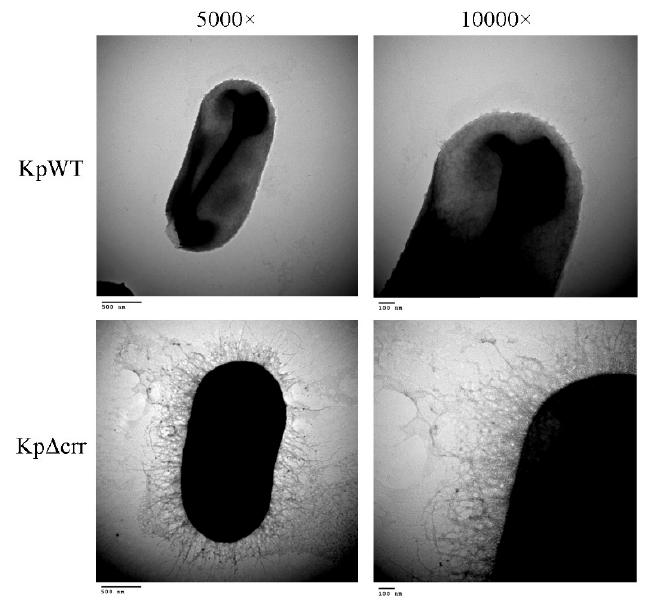
Figure 1. Phenotypic characteristics of the crr mutant in Klebsiella pneumoniae STU1. Representative TEM images from three independent experiments. KpWT: K. pneumoniae STU1 wild-type. Kp ∆ crr: K. pneumoniae crr mutant.